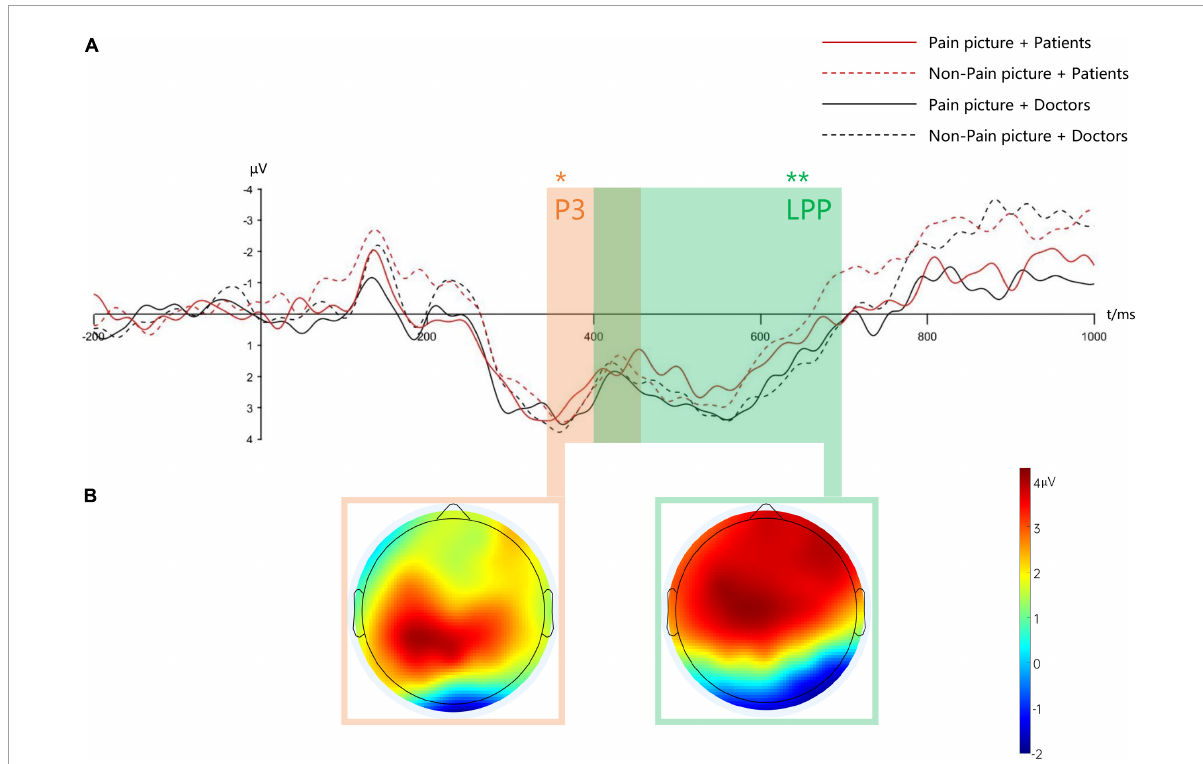
FIGURE3 Mean waveform and mean topographic map under low moral text material. Panel (A) shows the mean waveforms of positive 300 (P3) and late positive potential (LPP) (selected electrode points are FCz, Cz, Pz, C3, C4, CP3, CP4), respectively, * indicates p < 0.05; ** indicates p < 0.01; panel (B) shows the mean topographic map of P3 (350–450 ms) and LPP (400–700 ms) for a specific time